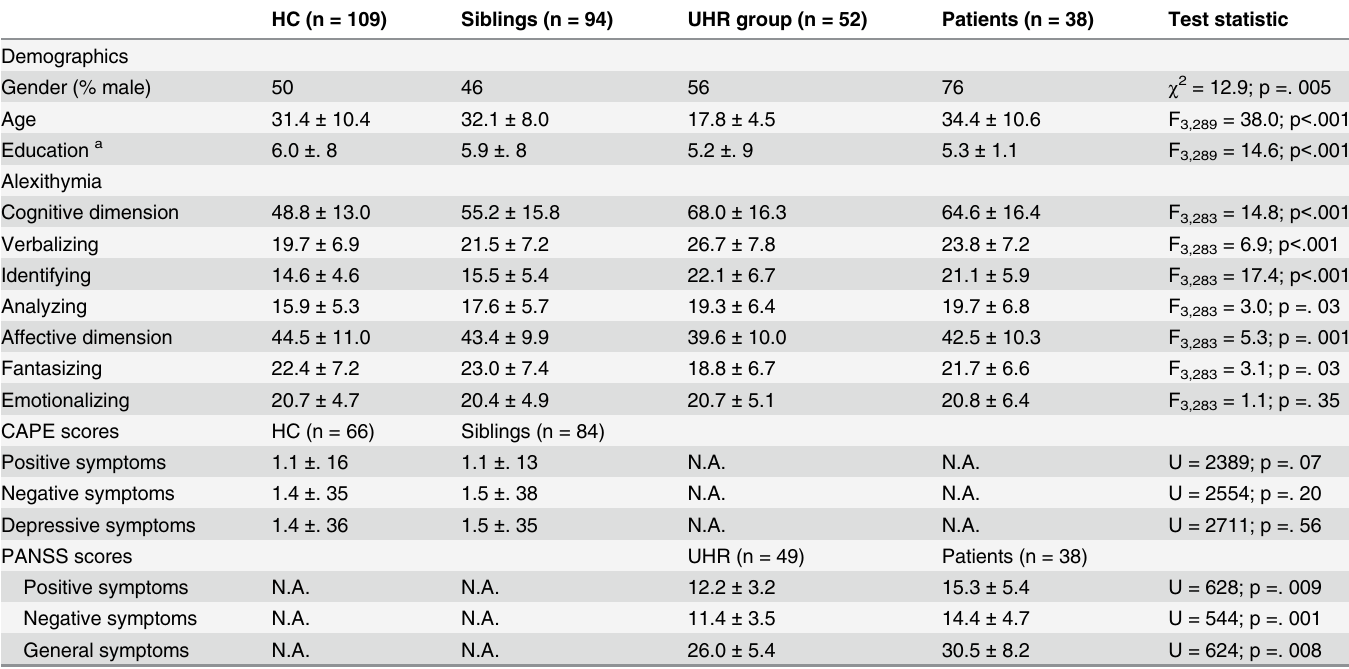
Table 1. Means and standard deviations of demographic variables and alexithymia scores per group and test statistics of group